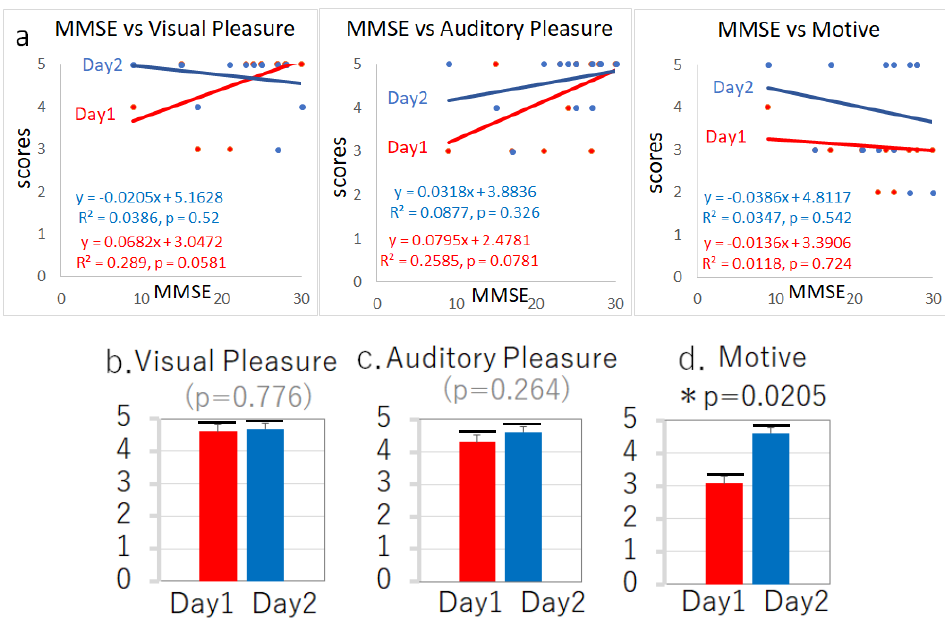
Figure 2. Confirmation of the participant psychological reaction scores from one to five. ( a ) After digital art entertainment experience, three questions were asked and recorded by experimenters. Each linear regression analysis result is denoted by a blue (Day 1) or red (Day 2) formula and the square of correlation coefficient (R 2 ). ( b – d ) The results of reactive scores (shown in a) between Day 1 and Day 2 were compared by one-way ANOVA (p: probability).